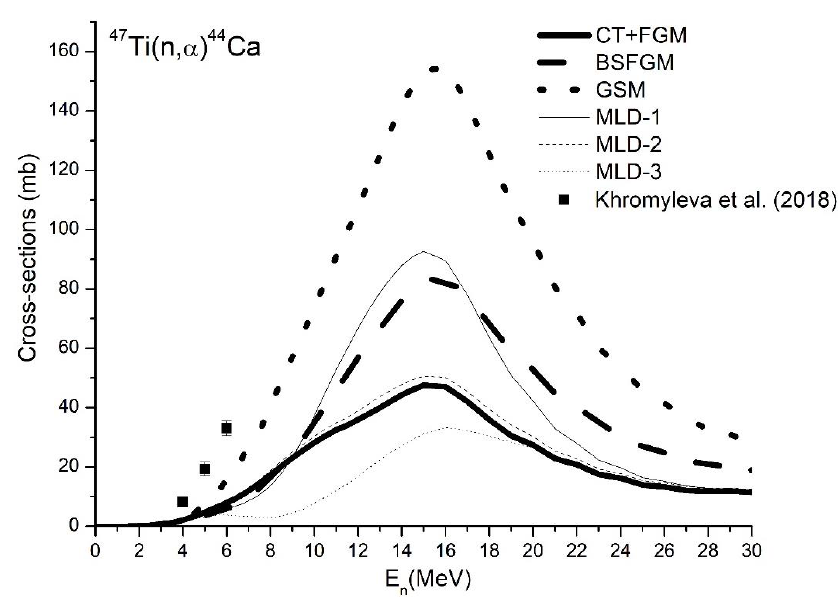
Figure 2: The comparison of the theoretically calculated excitation functions with experimental data [24] for 47 Ti (n, α) 44 Ca